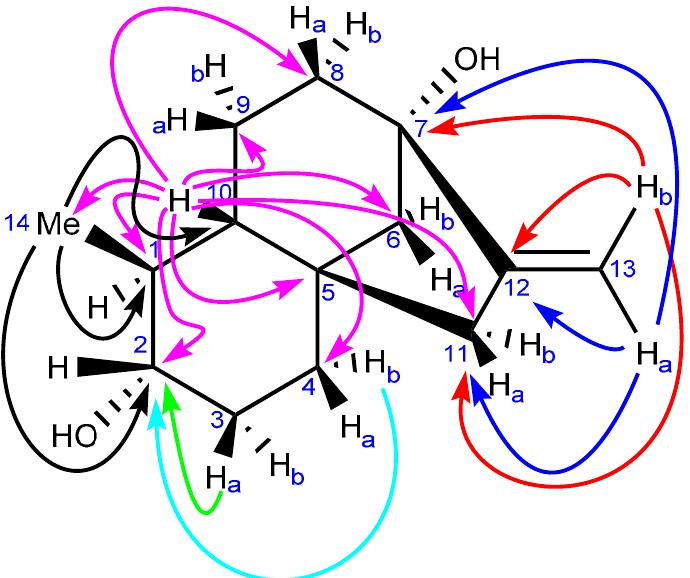
Figure 5. Key correlations in the HMBC spectrum of the second new compound isolated from the broth (monicanol).